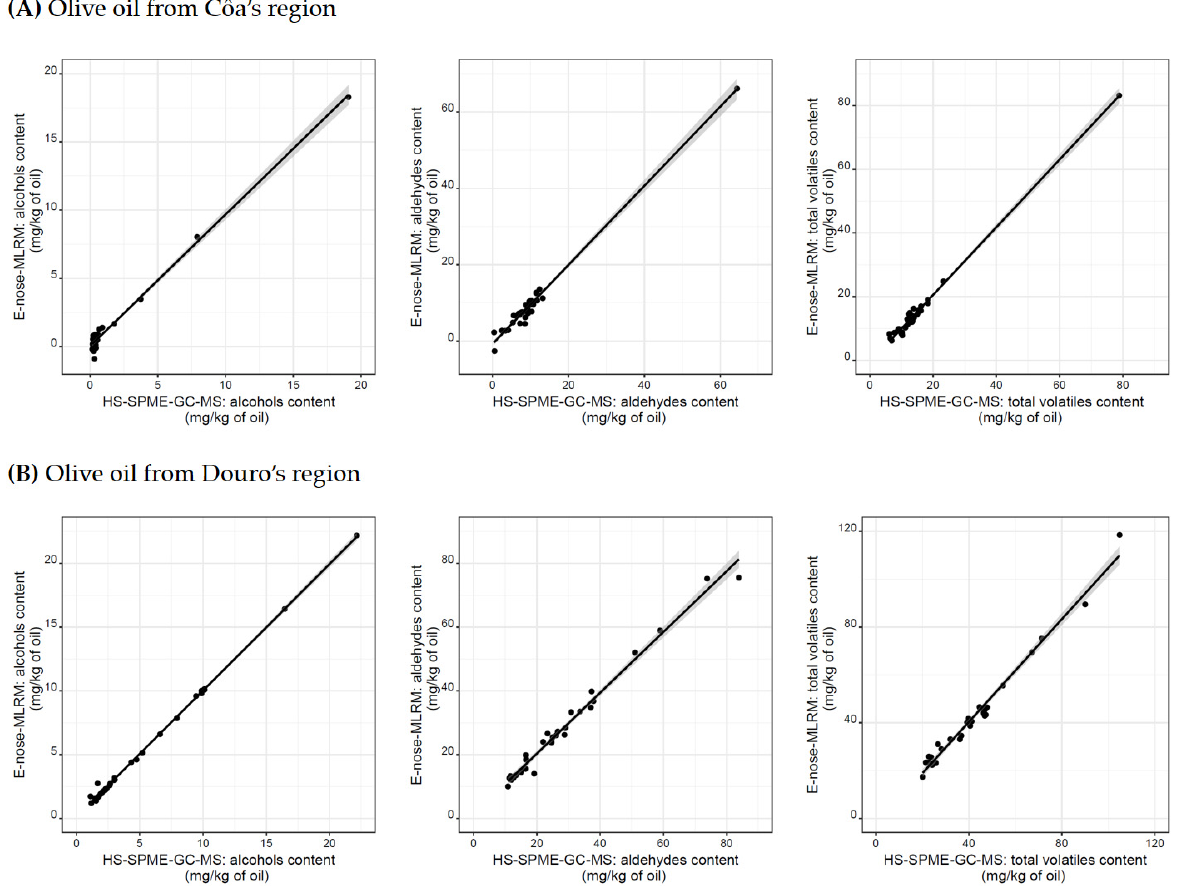
Figure 5. Contents (in mg/kg of oil) of volatiles predicted by the MLRMs established based on the selected feature extracted variables from the electrical resistance signal curves acquired by the nine-MOS sensors comprised on the lab-made E-nose, versus the experimental data determined by the HS-SPME-GC-MS technique.